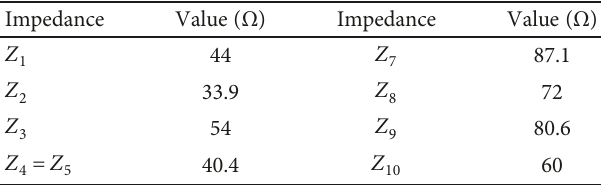
Table 2: Microstrip line impedances.